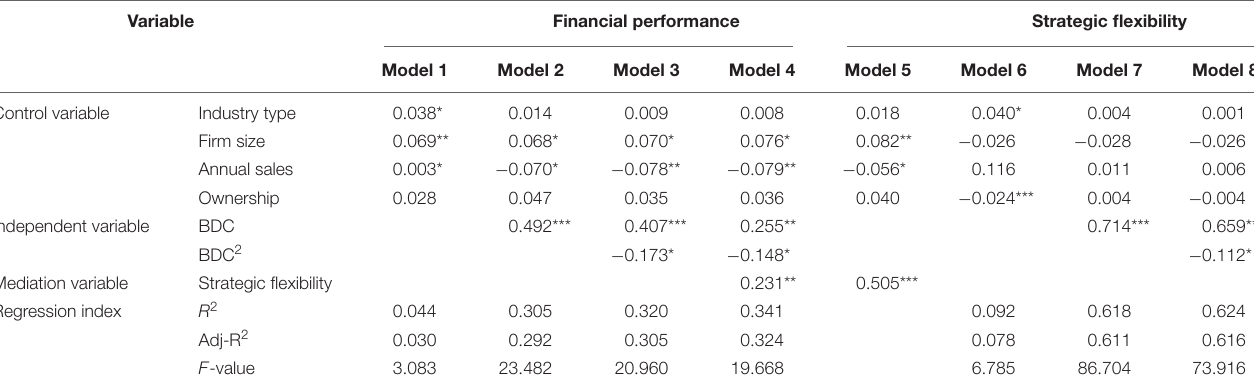
TABLE 5 | Regression test results of main effect and the mediating effect.